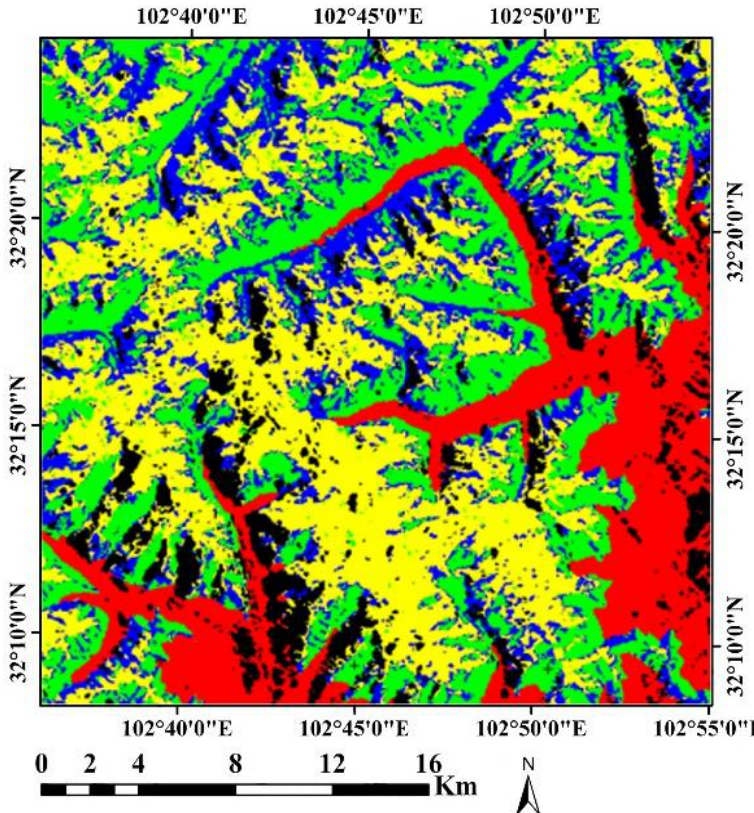
Figure 8. Snow status and status change between 22 February 2008 and 24 May 2008. Areas where snow melted completely or the snow status was Dry-No are blue. Areas of no change (Dry-Dry or No-No) are green. Areas of snow melting (Dry-Wet) are yellow. Areas below the tree line are